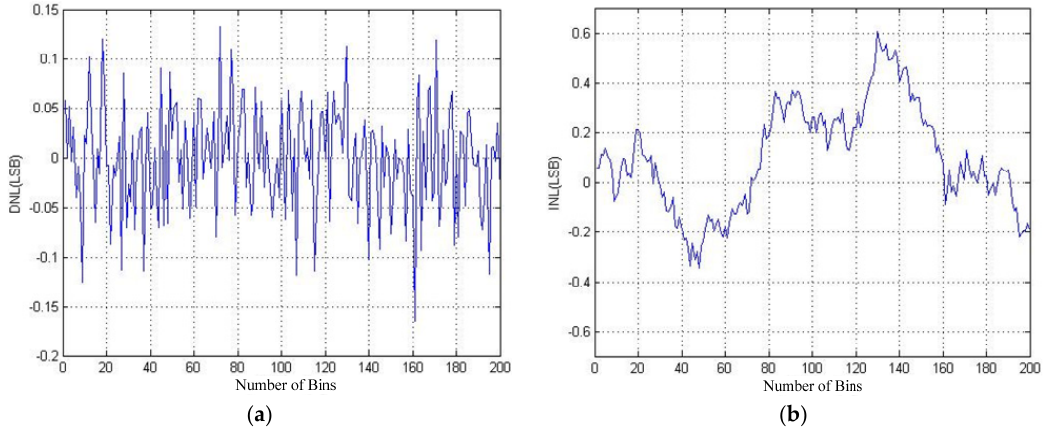
Figure 11. Nonlinearities of proposed DTC system. ( a ) DNL; ( b ) integral nonlinearity (INL).